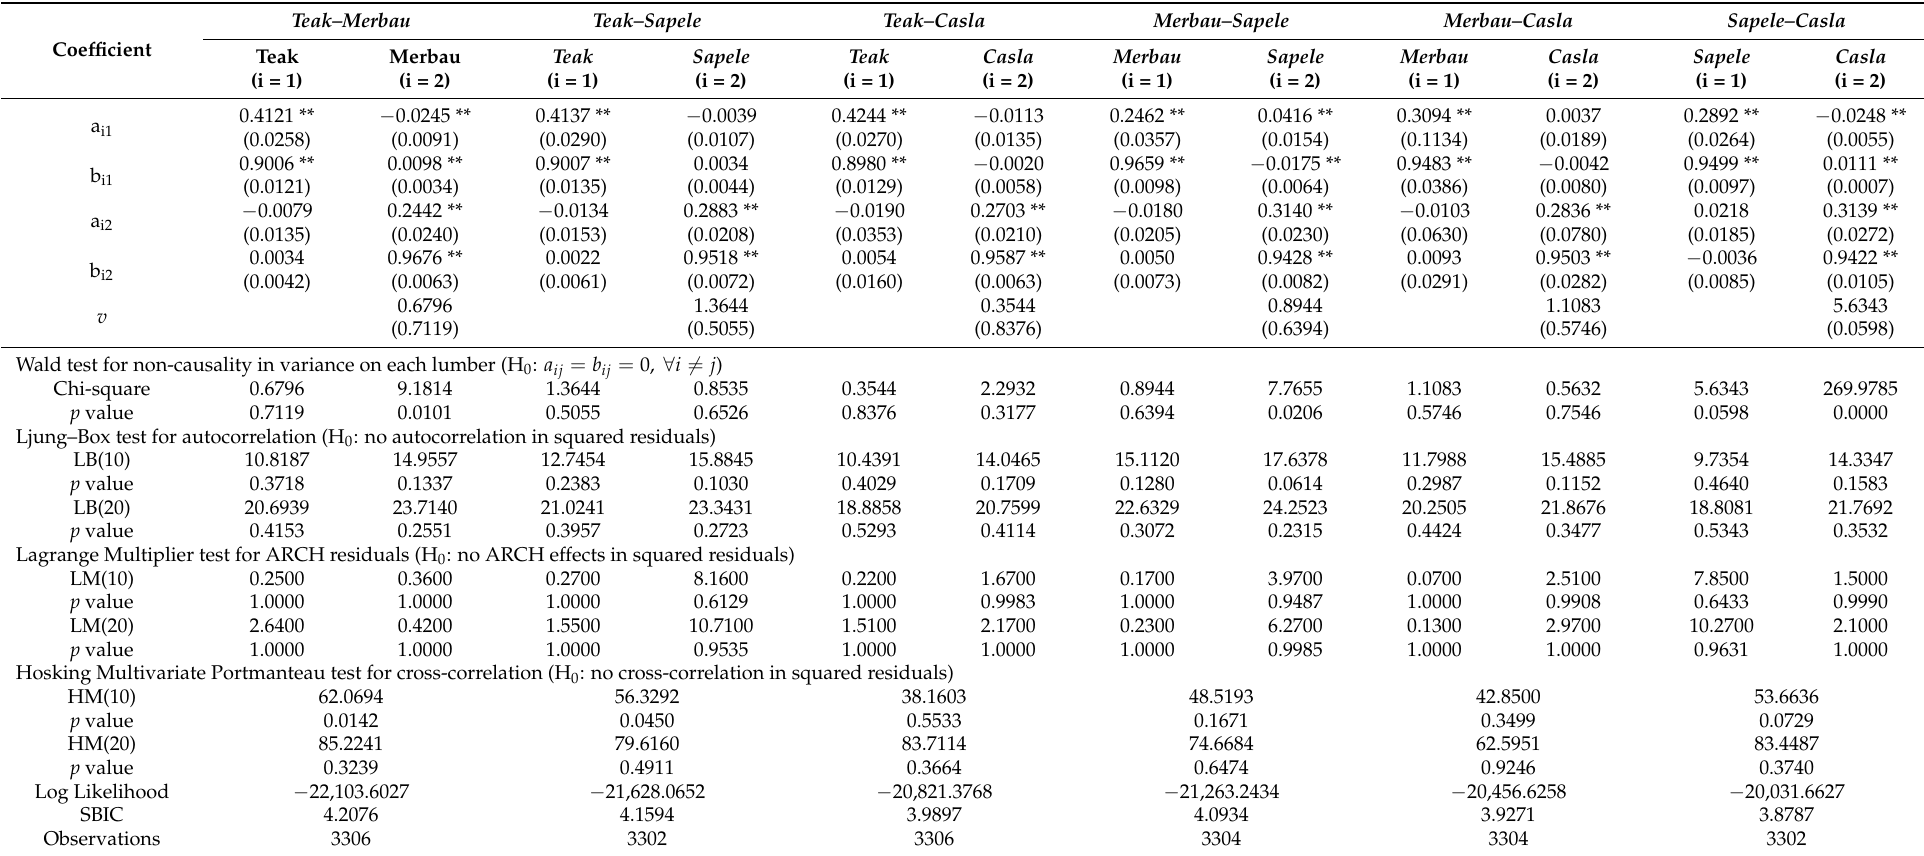
Table 4. The empirical results of the Baba–Engle–Kraft–Kroner (BEKK) GARCH